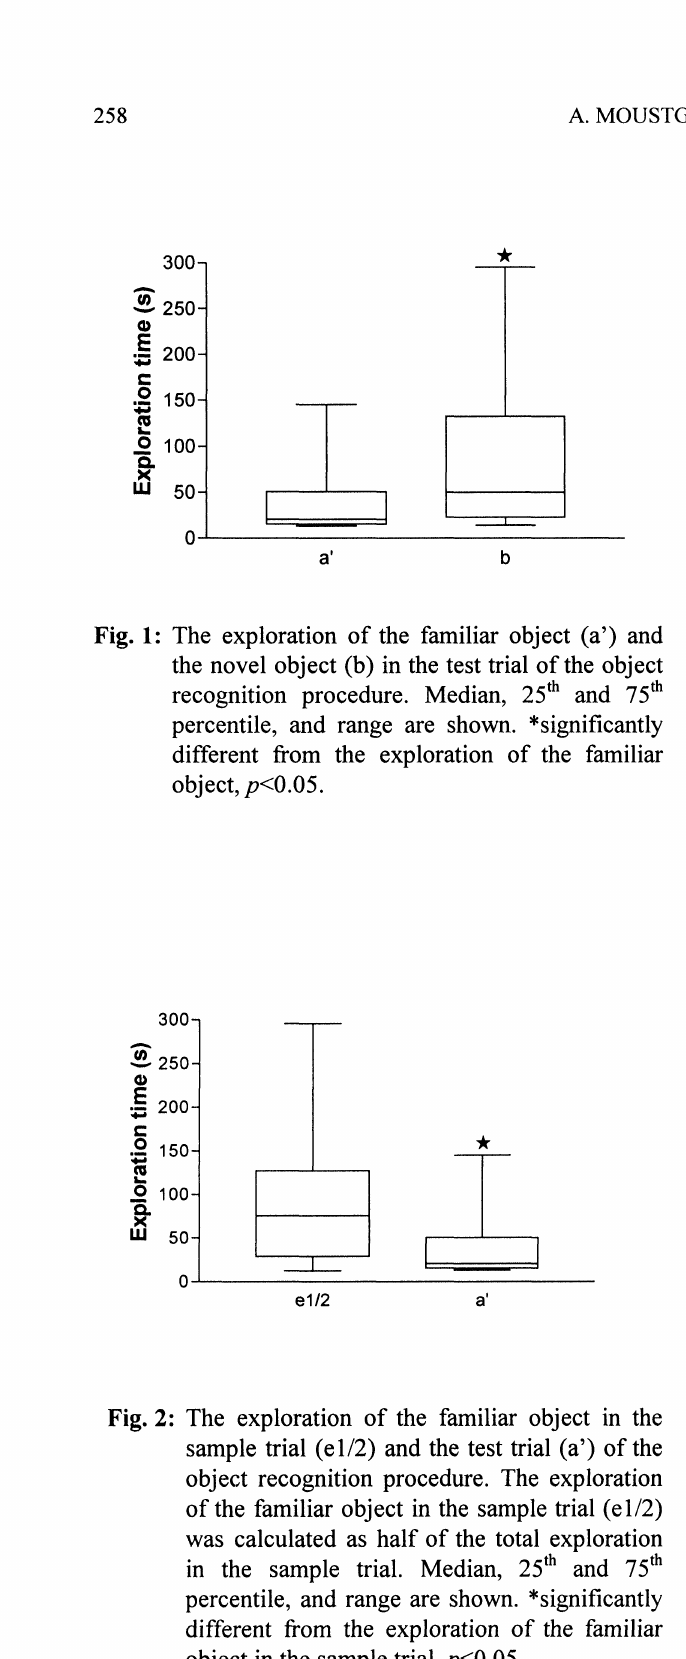
Fig. 2: The exploration of the familiar object in the sample trial (e 1/2) and the test trial (a’) of the object recognition procedure. The exploration of the familiar object in the sample trial (el/2) was calculated as half of the total exploration in the sample trial. Median, 25 th and 75 th percentile, and range are shown. *significantly different from the exploration of the familiar object in the sample trial,